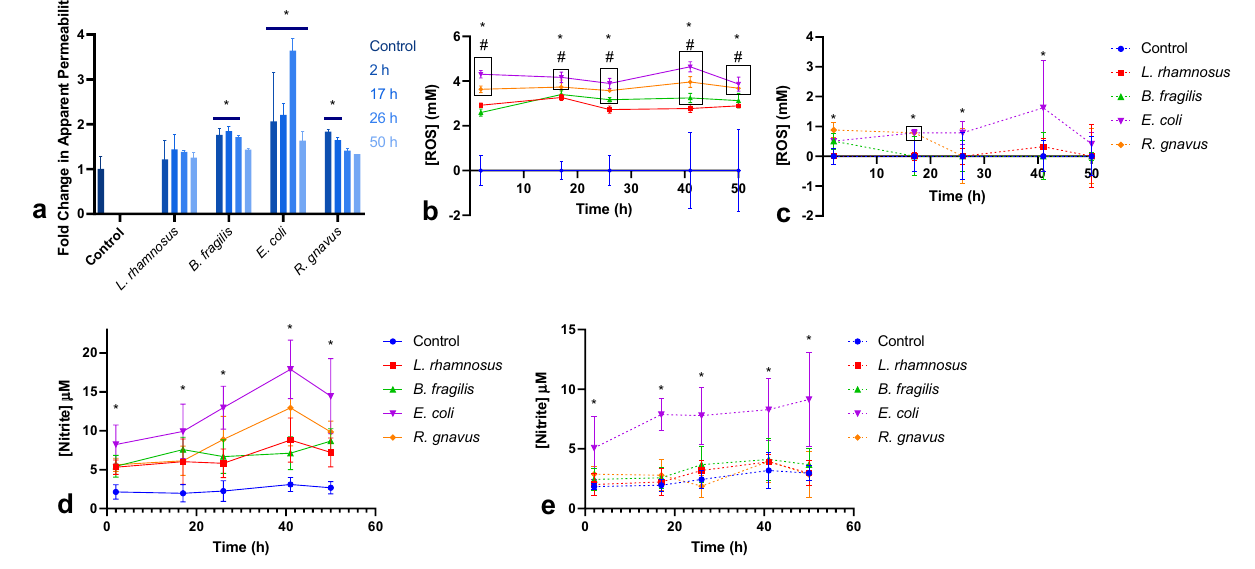
Figure 4. Spent medium from microbe co-cultures increases monolayer permeability due in part to elevated ROS and resultant RNS, which can be reduced via NAC supplementation. ( a ) Fold change in monolayer apparent permeability, measured via Lucifer Yellow, after 24 h exposure to conditioned media collected at 2, 17, 26, and 50 h relative to controls incubated in fresh media [Control n = 6, L. rhamnosus, B. fragilis, E. coli, R. gnavus n = 2, * = Significant difference compared to control ( B. fragilis p values range from ns to p = 0.03, R. gnavus p values range from ns to p = 0.03, E. coli p values range from p = 0.002 to p < 0.0001)]. ( b ) Reactive oxygen species concentration in apical media over the course of 50 h of co-culture [n = 10 samples from 5 independent experiments, * = Significant difference of all co-culture groups compared to control (All groups p < 0.0001), # = Significant difference of boxed groups compared to L. rhamnosus co-cultures ( B. fragilis p value ranges from ns to p = 0.03, E. coli p value ranges from p = 0.002 to p < 0.0001, R. gnavus p value ranges from p = 0.02 to p < 0.0001)]. ( c ) Reactive oxygen species concentration with NAC supplementation of the apical media (n = 10 samples from 5 independent experiments, * = Significant difference compared to control ( E. coli p value ranges from ns to p < 0.0001, R. gnavus ranges from ns to p = 0.04, L. rhamnosus, B. fragilis ns), boxed group shares significance). ( d ) Nitrite concentration in apical media over the course of 50 h of